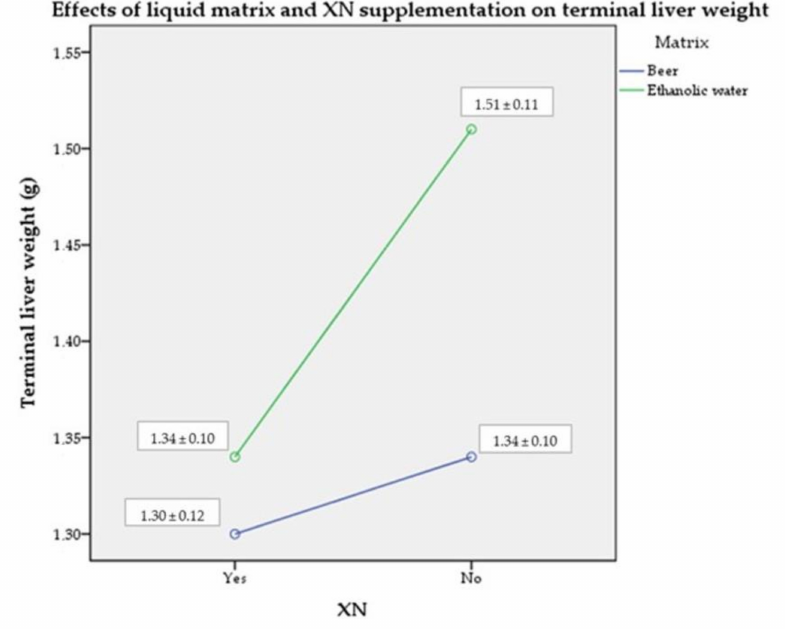
Figure 4. Mean ( ± SD) terminal liver mass of mice by treatment group ( n = 10). Abbreviations: XN—xanthohumol; SD—standard